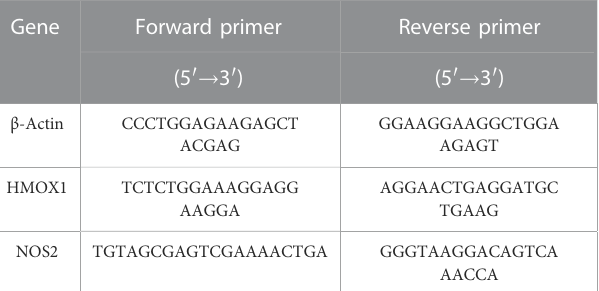
TABLE 1 PCR primer sequences.